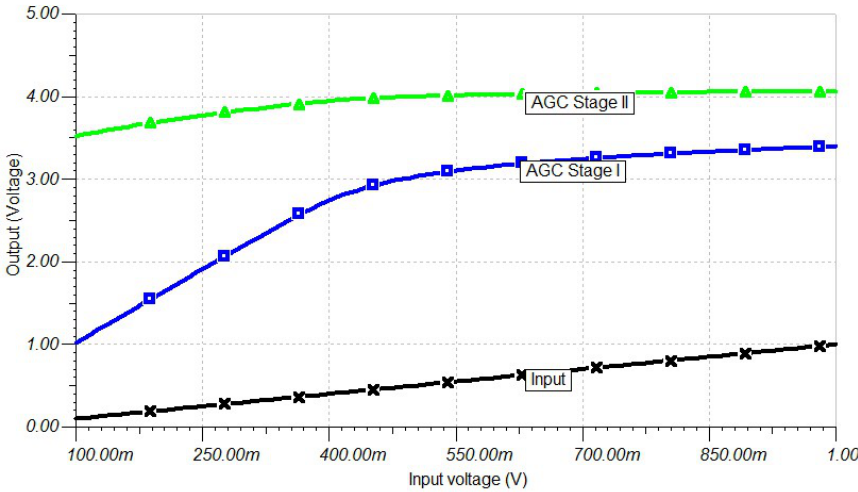
Fig. 9. DC signal characteristic of two stage AGC circuit using IC LM13700 from varied input voltage 0.1V DC to 1V